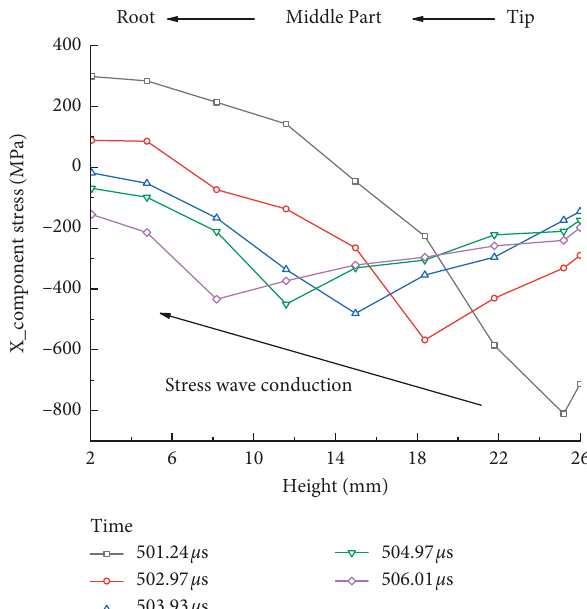
Figure 18: Distribution of the radial stress on different positions of rubbing